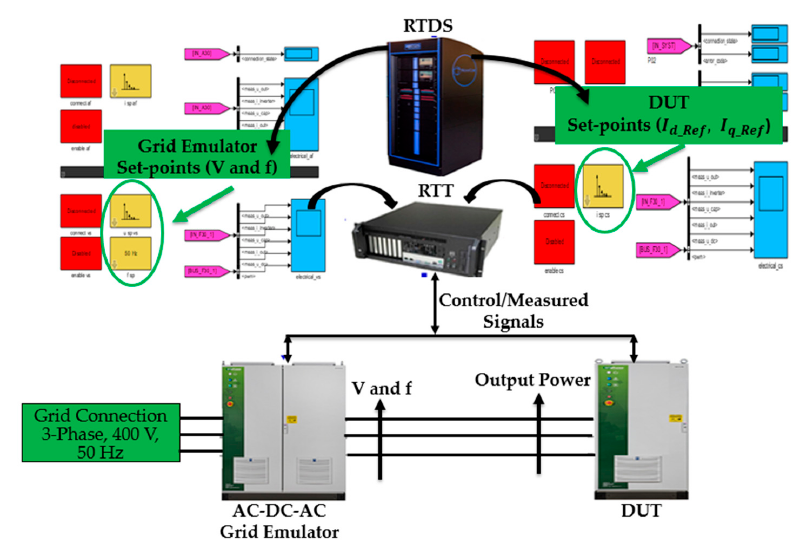
Figure 2. Interactions between the components of the PHIL setup.